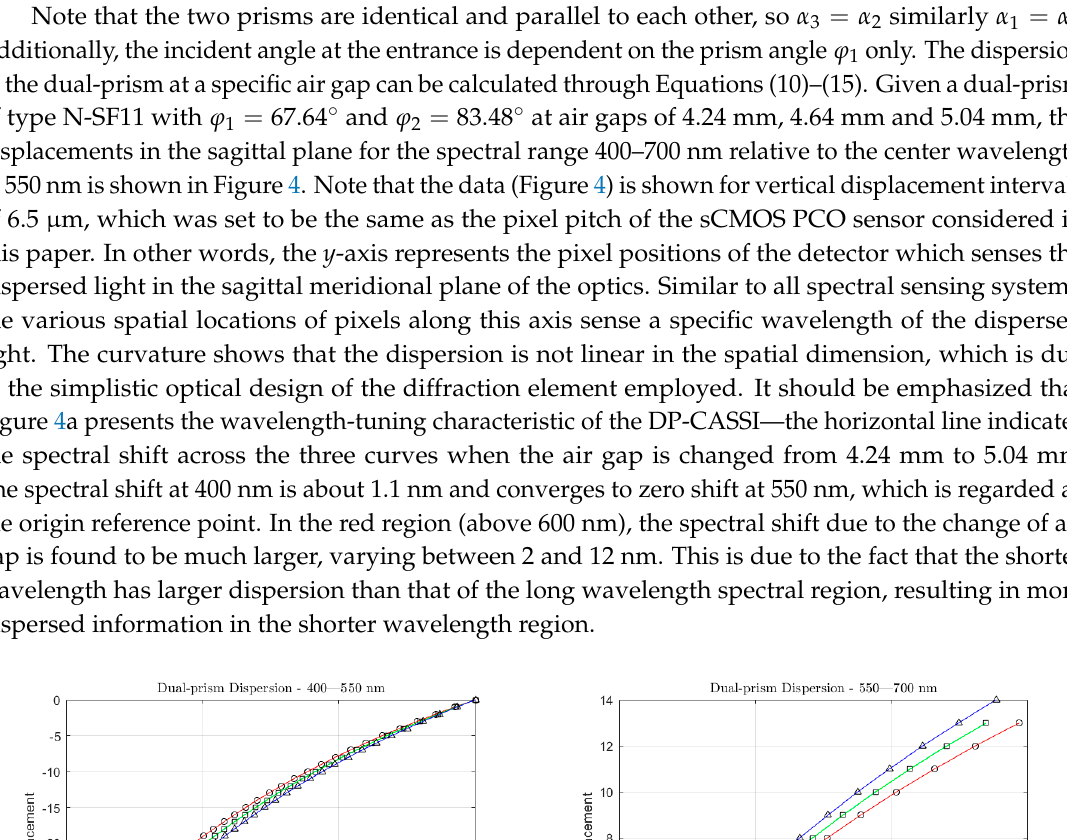
Figure 5. Ray diagram of the Dual-Prism Coded Aperture Snapshot Spectral Imager simulated by the OSLO lens design software.